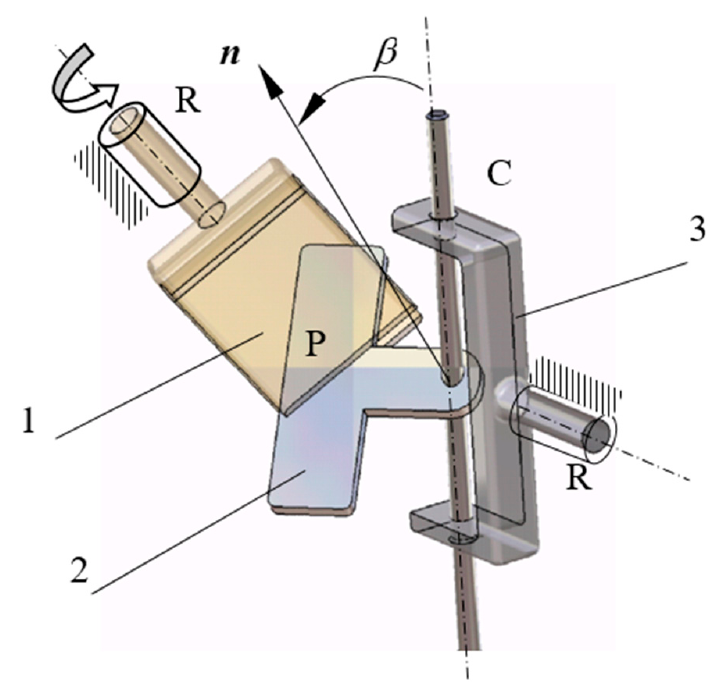
Figure 3. The spatial RPCR mechanism.